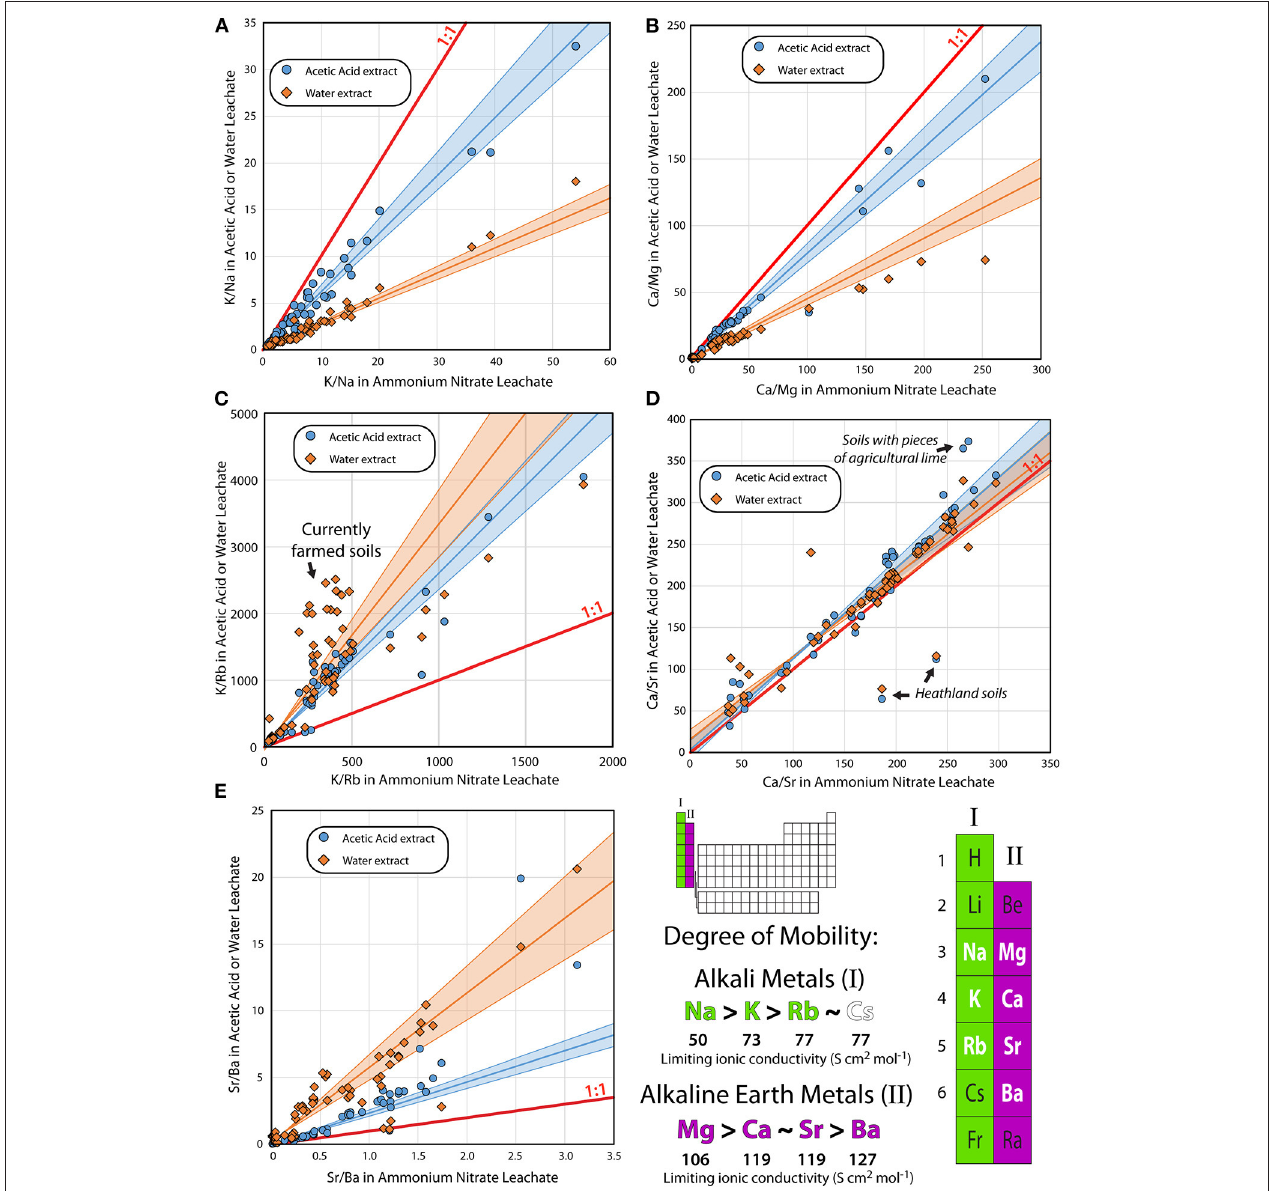
FIGURE 3 | Relative mobility of the major alkali metals and alkaline earth metals (groups I and II in the periodic table). (A–E) Ratios in leachates of water (orange diamonds) and 0.2M acetic acid (light blue circles) on the y-axis compared with the ratios of 1.0M ammonium nitrate leachates of the same soil sample. Also shown are 1:1 and best fit regression lines and 95% confidence intervals [calculated using IsoplotR—Vermeesch (2018)] for the data. Slopes shallower than 1:1 indicate that the element in the numerator is more mobile in the weaker water- and acetic acid leachates than in the ammonium nitrate leach. Slopes steeper than 1:1 indicate